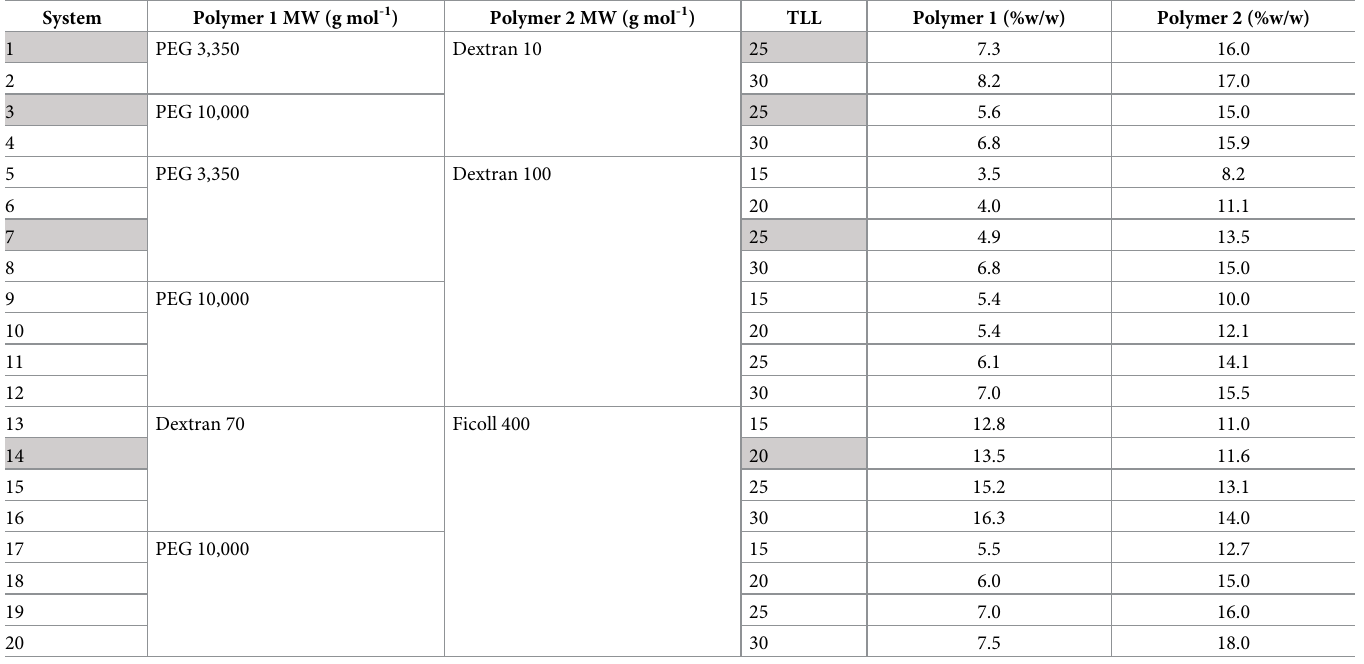
Table 1. Composition and parameters of selected polymer-polymer ATPS for the fractionation of exosomes and their contaminants.